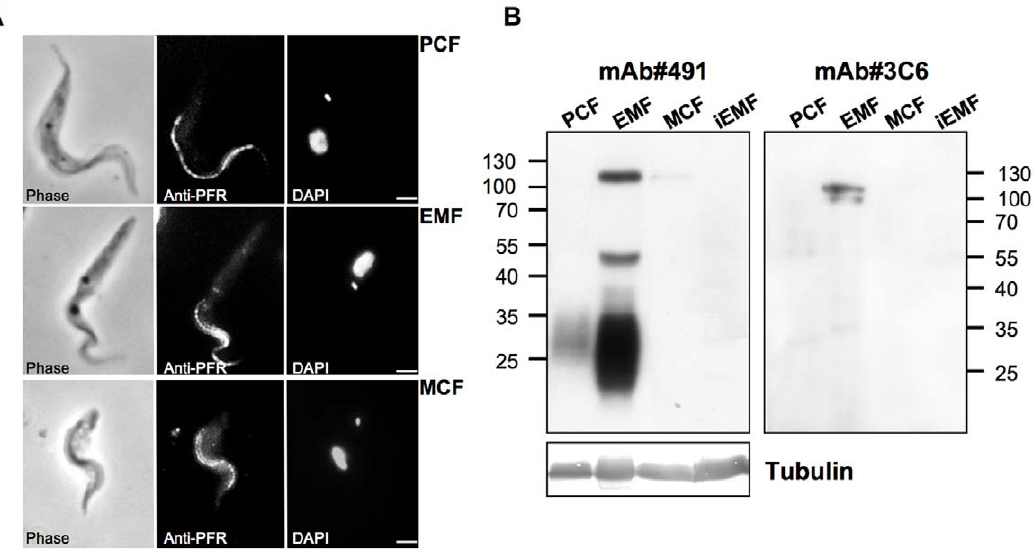
Figure 3. Morphological features and molecular markers analysis during metacyclogenesis. A, Wild-type individual IL 3000 cells were labeled with monoclonal anti-PFR antibody during metacyclogenesis. For orientation the fixed cells were also stained with 4,6-diamino-2- phenylindole (DAPI) and visualized in phase contrast. Scale bar=1 m m. B, Western blot analysis of stage specific markers during the metacyclogenesis. 10 6 cells of IL3000 were loaded per well. Tubulin was used as a loading control. Molecular weights are indicated on the blots side. iEMF: induced EMF in the absence of serum. Identical results were observed with the other T. congolense isolates and with transfected parasites.